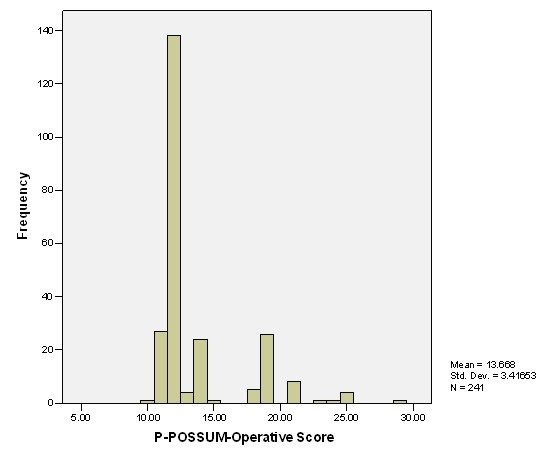
Distribution of patients according to Operative Score.